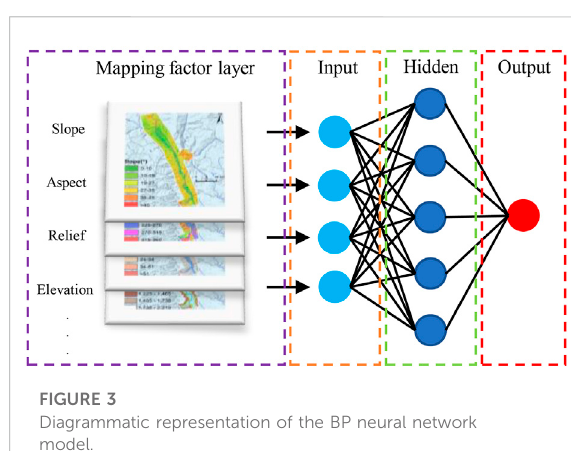
FIGURE 3 Diagrammatic representation of the BP neural network